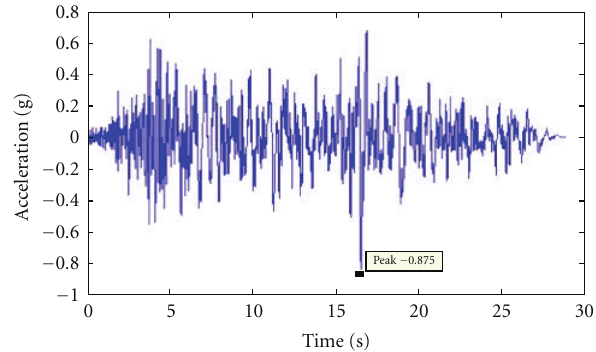
Figure 9: Time-compressed acceleration record for the 1992 Landers earthquake.